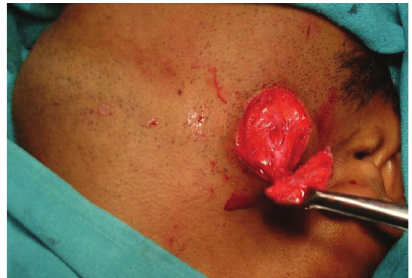
Figure 9: Bony excess resected at angle.